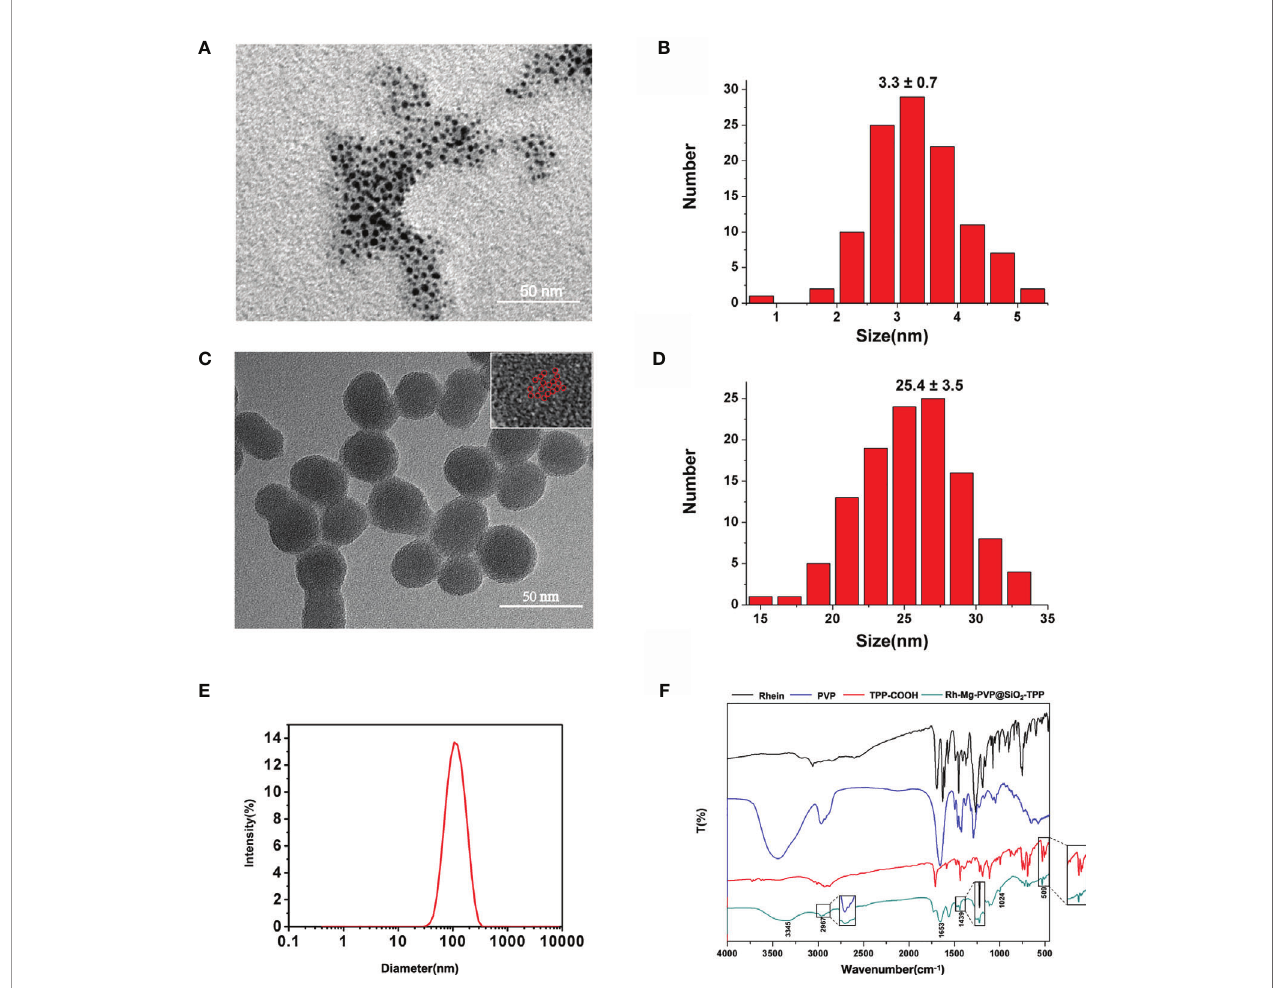
FIGURE 1 | (A) TEM image and (B) size distribution of Rh-Mg coordination polymer nanodots. (C) TEM image and (D) size distribution of Rh-Mg-PVP@SiO 2 -TPP NPs. Individual Rh-Mg coordination polymer nanodots are outlined by red cycles. (E) Hydrodynamic size distribution of Rh-Mg-PVP@SiO 2 -TPP NPs. (F) FT-IR of